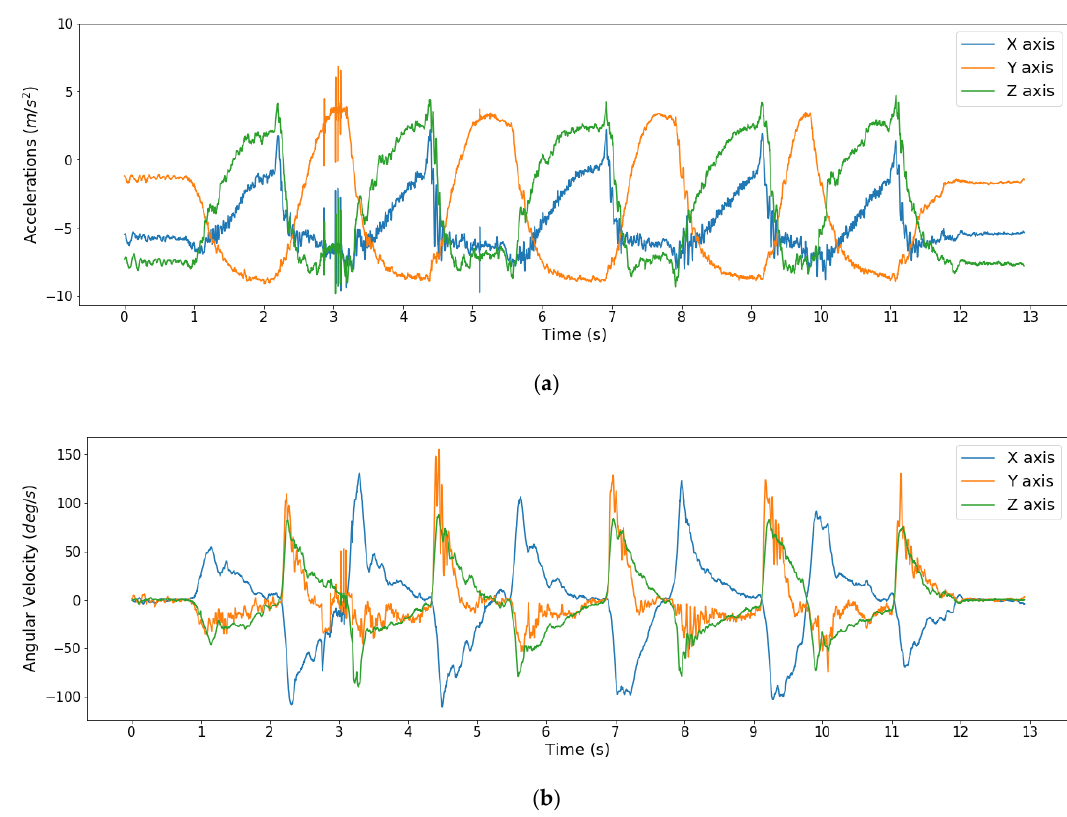
Figure 1. Raw tri-axial acceleration ( a ) and angular rotation ( b ) recorded from the elbow of a participant during spasticity assessment using the MAS.